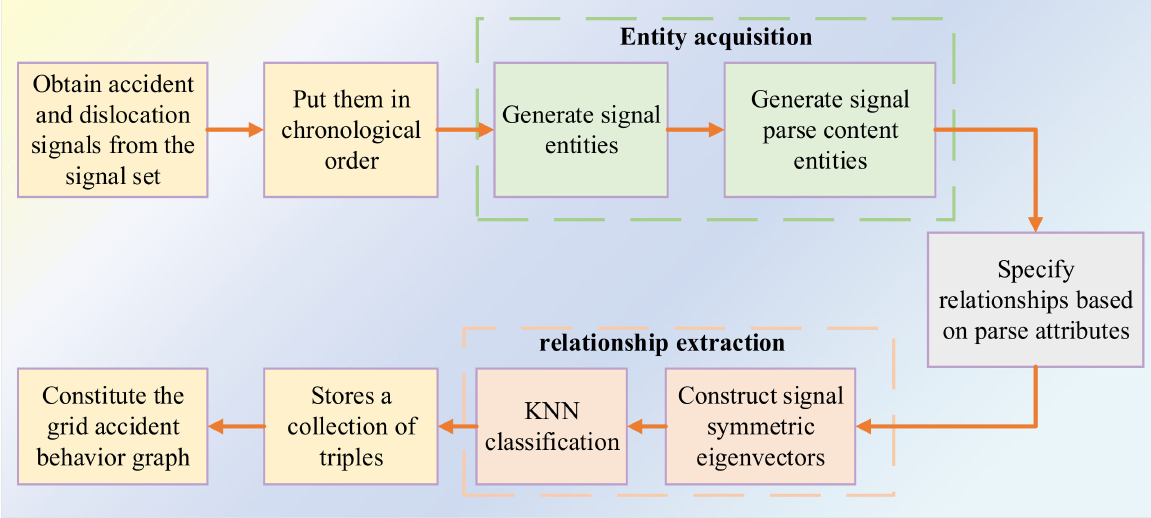
Figure 5. Construction process of power grid accident behavior